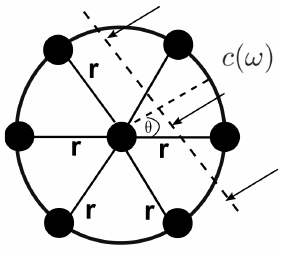
Figure 3. Geometry of sensor nodes and an incident plane wave. Filled black circles represent the